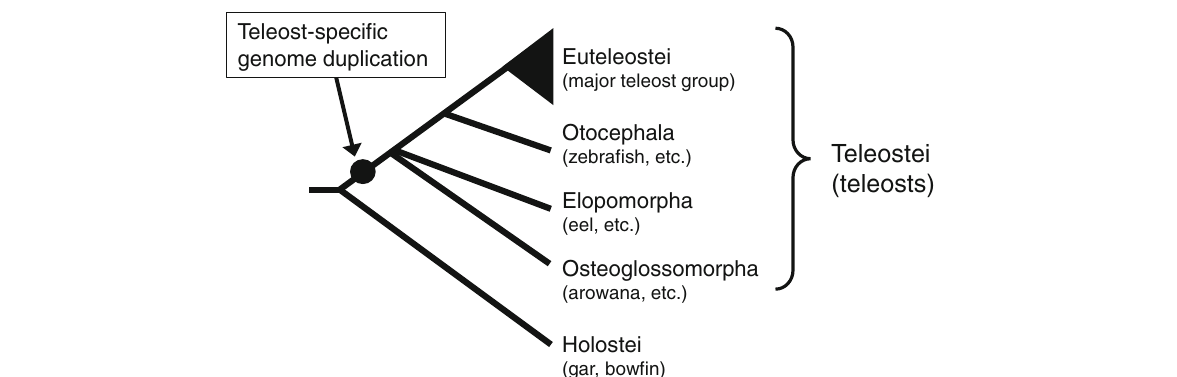
Fig. 1 Phylogenetic relationship among the fish lineages examined in this studyThe timing of teleost-specific genome duplication (TSD) is shown by a closed